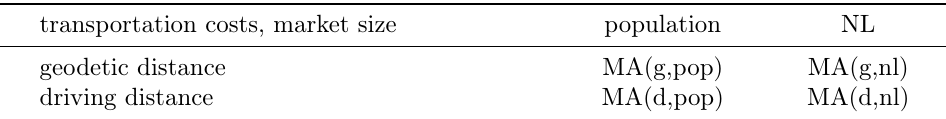
Table 3: Specifications of market